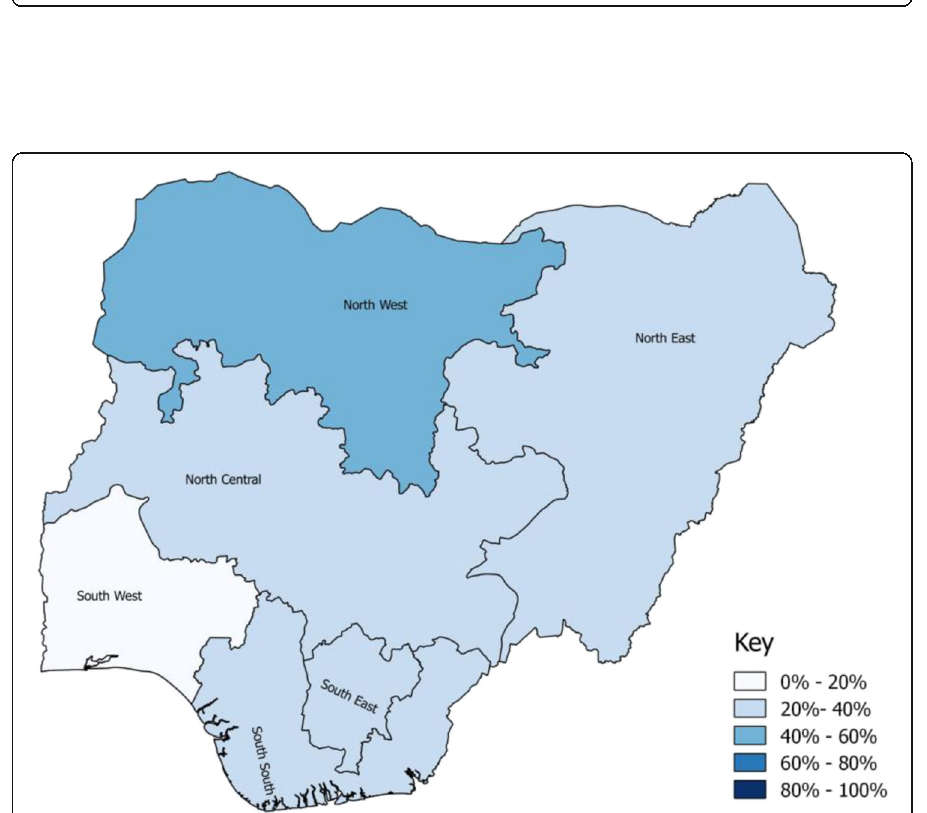
Fig. 3 Percentage of women believing that a husband is justified in beating his wife if she goes out without telling him, by region, NDHS